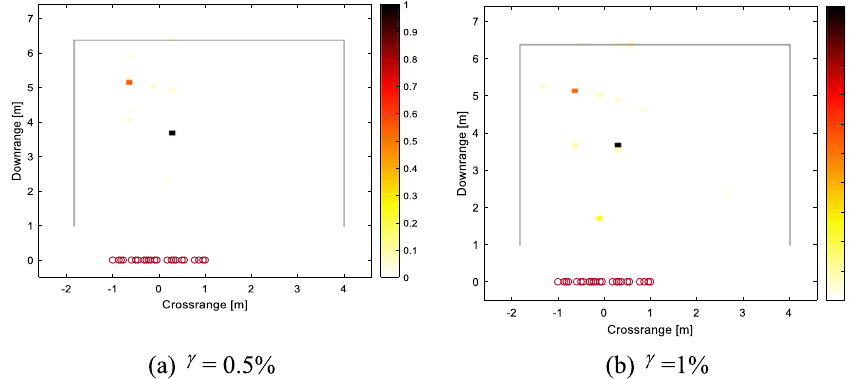
Fig. 7 Sparse reconstruction for two unknown targets